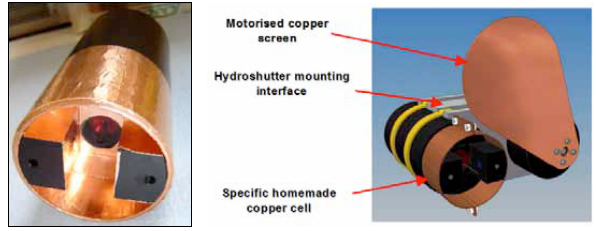
Fig 4 : Biofouling protection with a motorized copper shutter Fig. 4. Biofouling protection with a motorized copper